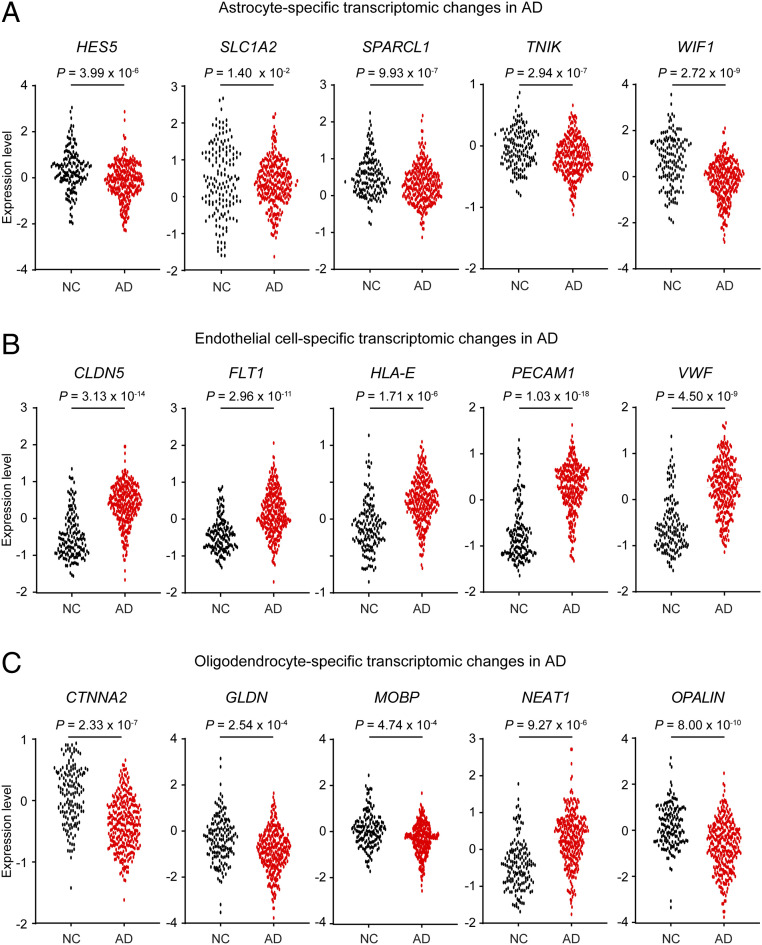
Validation of the cell type-specific transcriptomic changes in AD based on data from a large cohort microarray study. Dot plots showing the expression levels of DEGs specific to astrocytes (A), endothelial cells (B), and oligodendrocytes (C) in the prefrontal cortex from patients with AD (n = 310) and NC (n = 157) samples. Each dot represents the expression level from an individual subject. Source: Narayanan et al. (18). See also SI Appendix, Fig. S3 and Table S4.